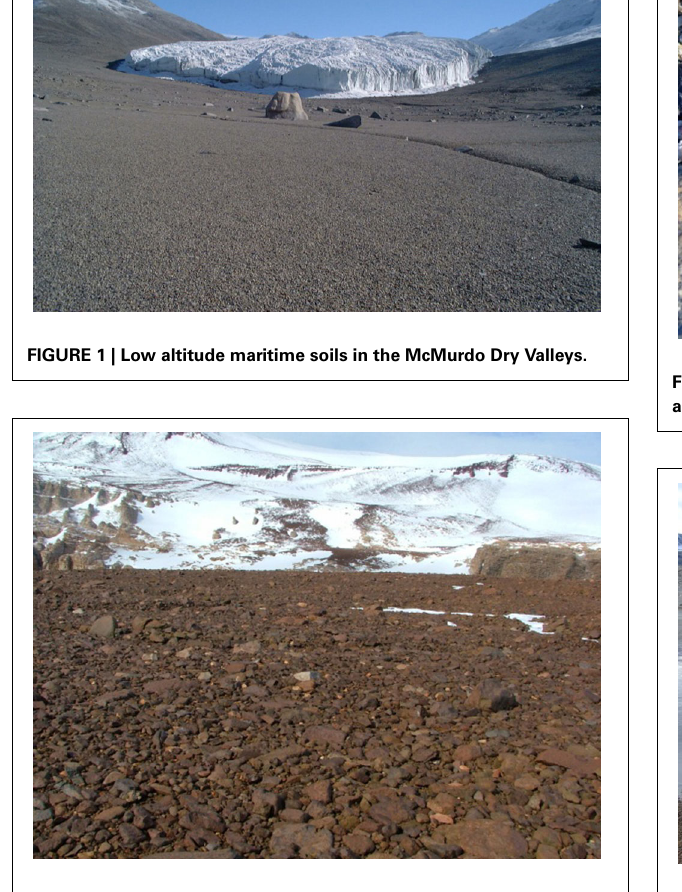
FIGURE 4 | Saturated soils and cyanobacterial mats associated with a shallow Dry Valley